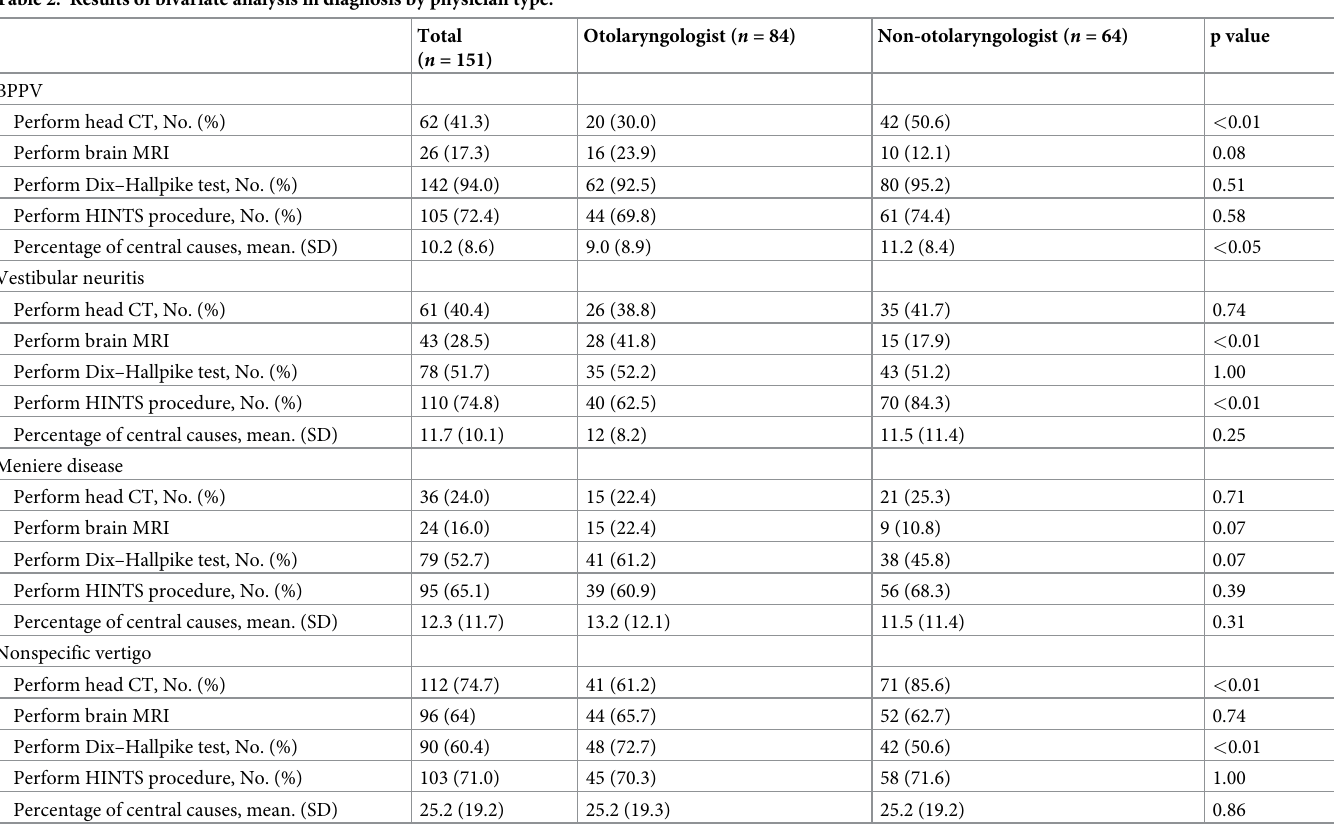
Table 2. Results of bivariate analysis in diagnosis by physician